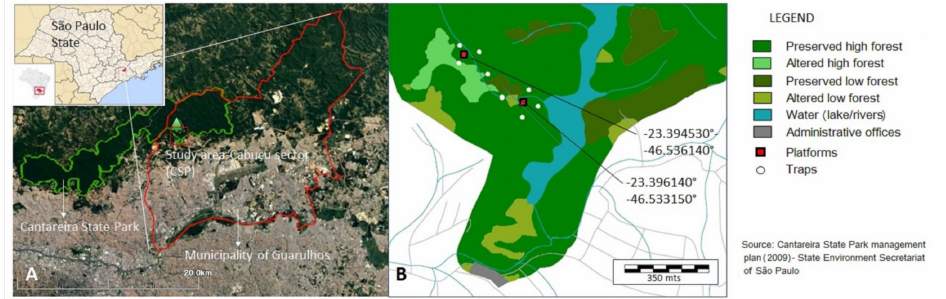
Figure 1. ( A ) Google Earth image (accessed on 30 July 2021)—limits of the Cantareira State Park (green), limits of the municipality of Guarulhos (red); study site (red square). ( B ) Thematic map, adapted from the Cantareira State Park Management Plan (2009), showing the platforms (red squares), the automatic trap installation sites (white dots), and the preserved vegetation belts of different tree heights (different shades of